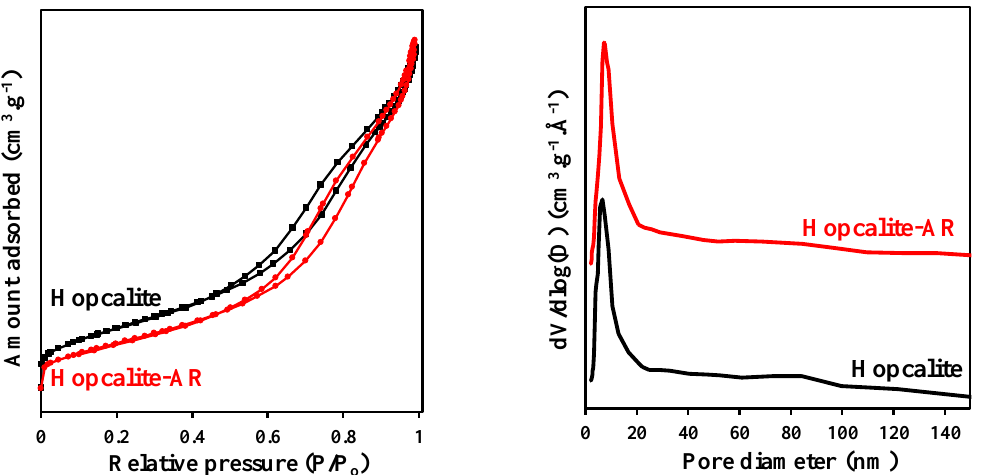
Figure 6. N 2 adsorption–desorption isotherms and pore size distribution of fresh Hopcalite and Hopcalite after reaction (Hopcalite-AR).